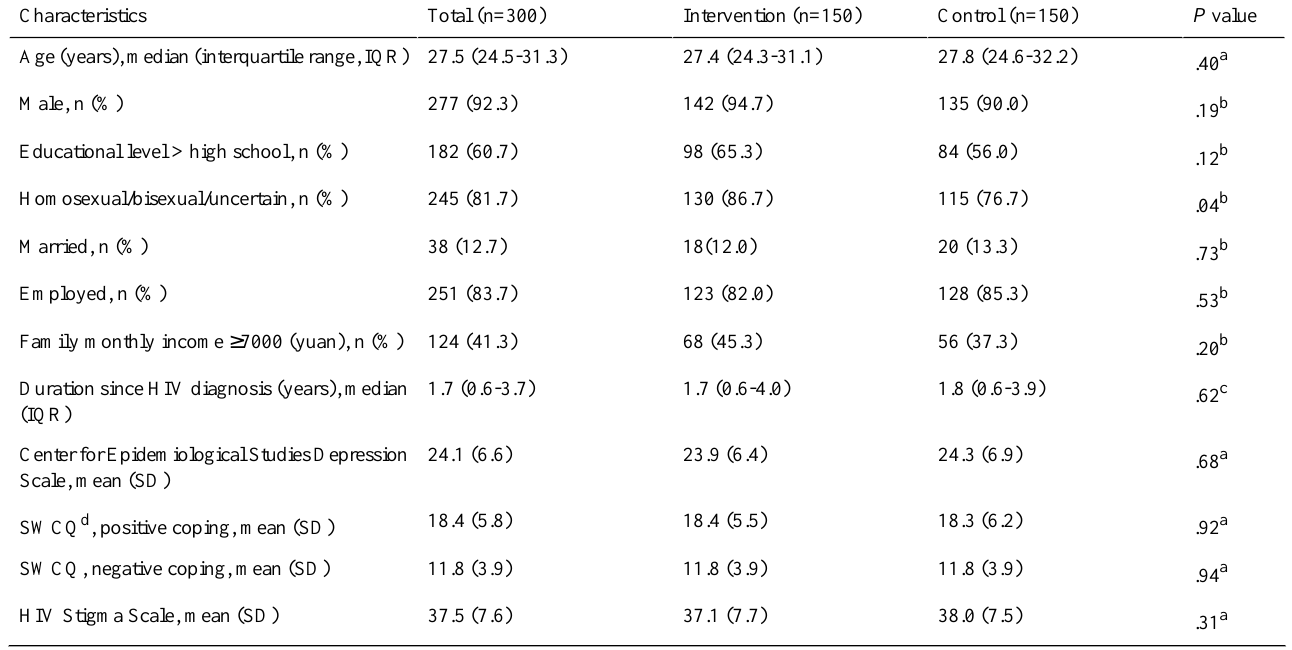
Table 1. Participants’characteristics for the intervention and control groups at baseline.